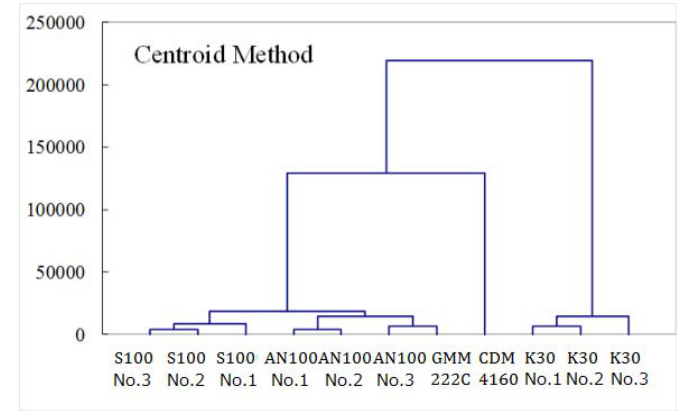
Figure 3. Cluster analysis using the data obtained on 25 February 2010. Air